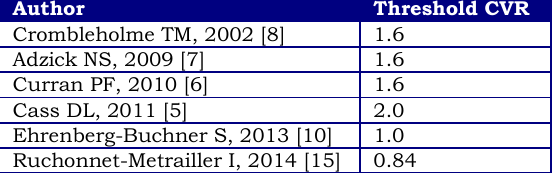
Table 1: Threshold values of CVR as reported in literature